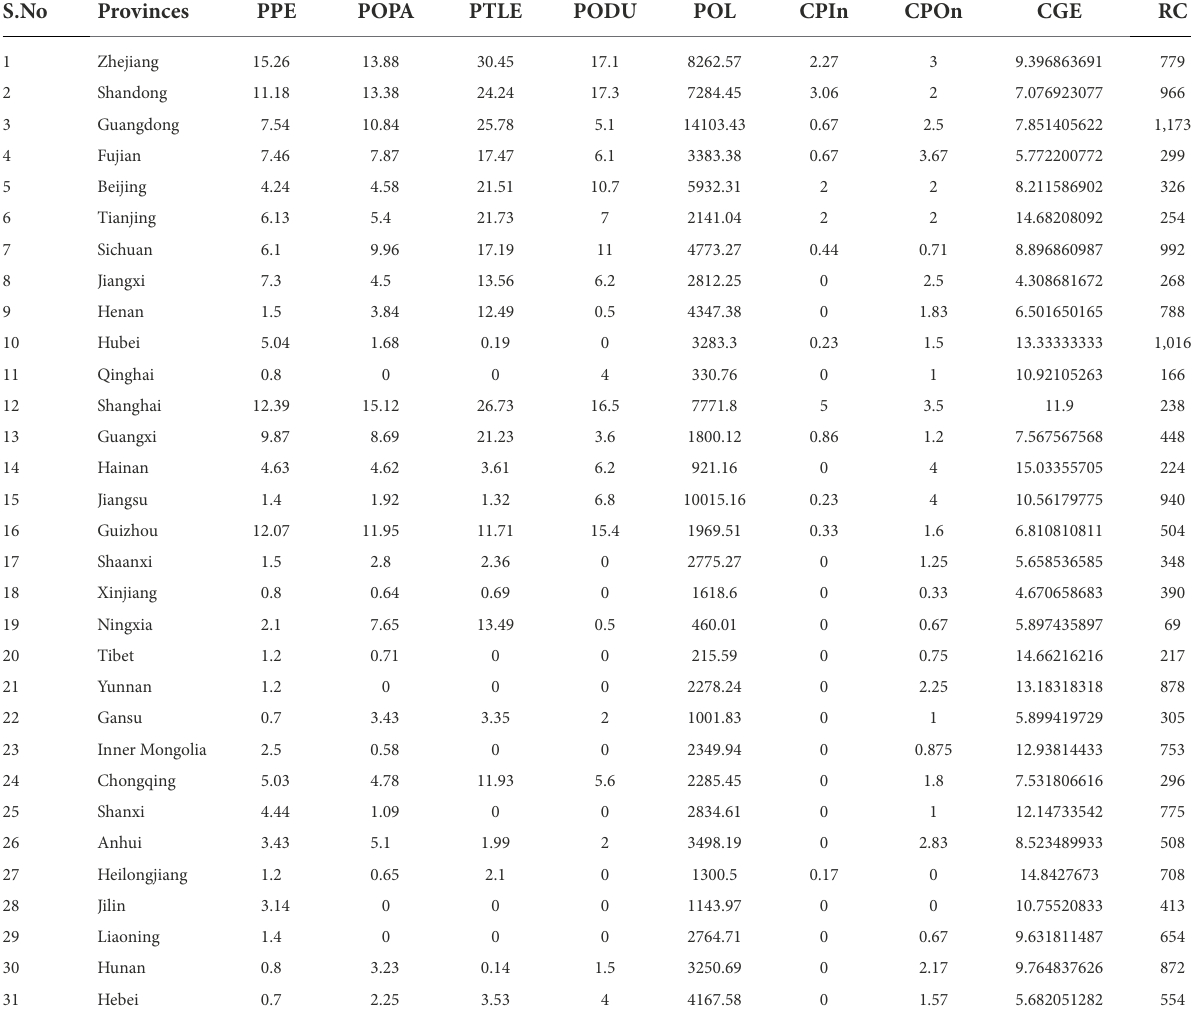
TABLE 2 Provincial data openness score